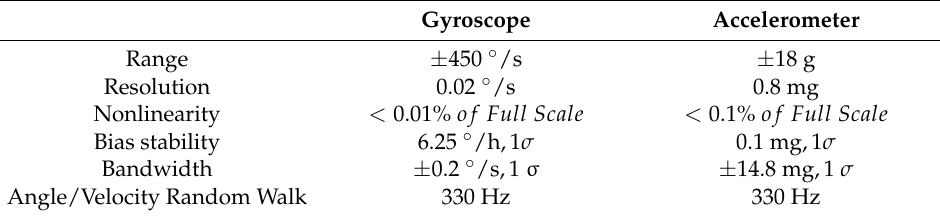
Figure 2. Korean utility helicopter, Surion. Table 1. IMU specifications (Analog devices ADIS 16488).